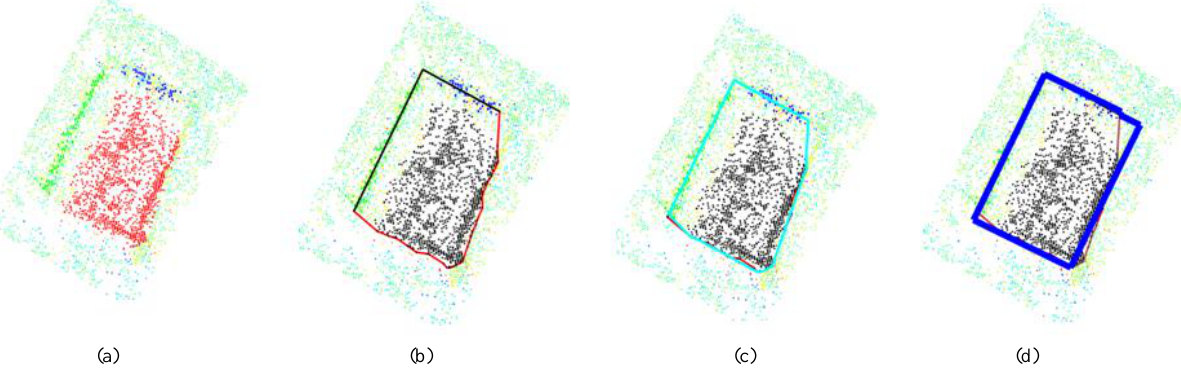
Figure 3: Reconstruction sequence for case 2 where both roof points and façade points are available: (a) Red points are the extracted roof points where green and blue points are the extracted façade points for the same building; (b) The red polygon represents the coarse boundary obtained by alpha shapes method after incorporating the reconstructed façades (shown as black lines); (c) Result of refining the coarse building outline by computing mean orientation of each vertex point and removing those consecutive vertices where there is no or very little change in the orientation direction; (d) Final result after adding rectilinear constraints the previous refined building boundary.